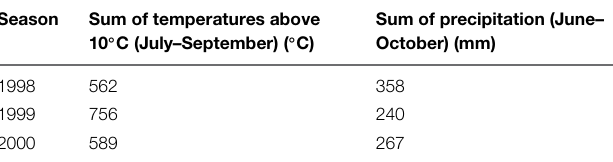
TABLE 1 | Sum of daily temperatures above 10 ◦ C (from July to September) and precipitation (from June to October) in seasons of 1998, 1999, and 2000 in Crop Research Institute in Prague, Czech